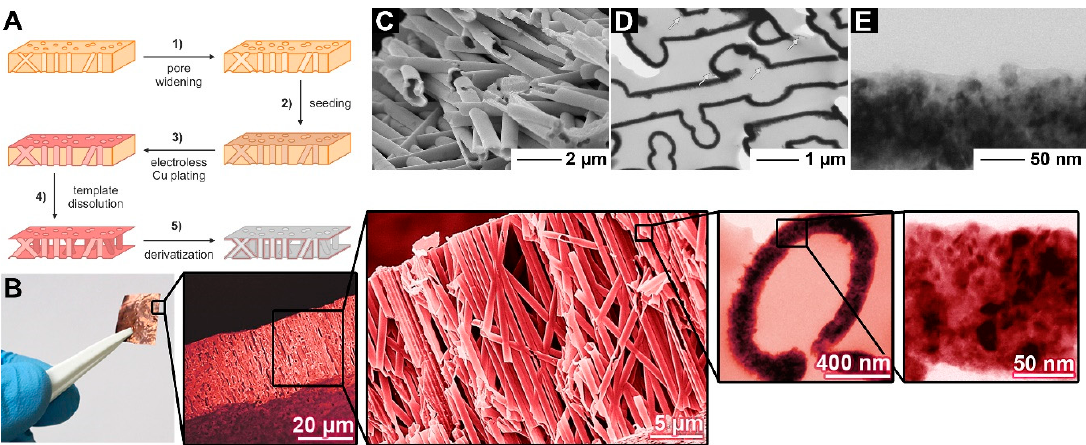
Figure 10. ( A ) Scheme of the deposition of 3D metal nanotube networks in commercial ion-track etched polymer membranes. ( B ) Collage of a photograph and false color SEM images, illustrating the multiscale architecture of a disordered Cu nanotube network, which ranges from the centimetre scale of the free-standing film to the tube walls composed of nanocrystalline Cu. ( C – E ) Electron micrographs showing the derivatization of a Cu nanotube network with an ultrathin Ni layer, which was applied by electroless plating. Reprinted (adapted) with permission from [63]. Copyright (2016) American Chemical Society.